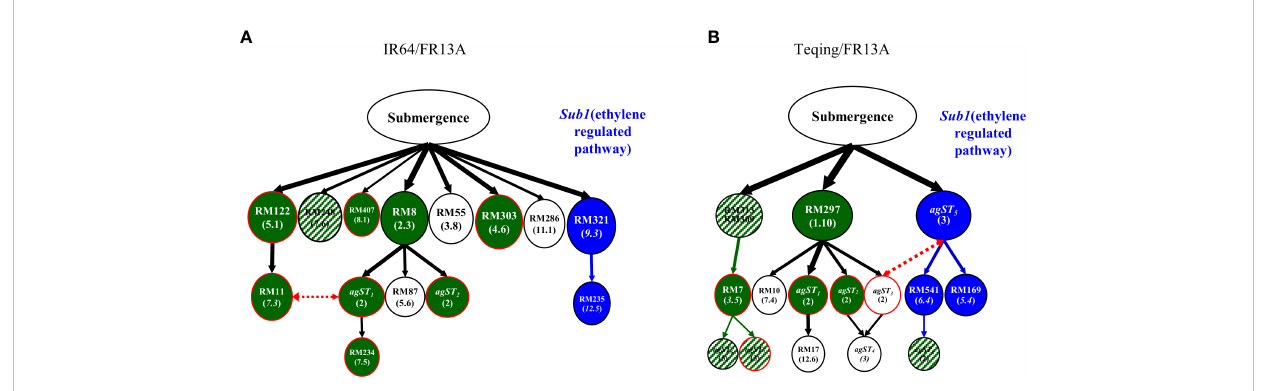
FIGURE 2 Genetic overlap between drought tolerance (DT) and submergence tolerance (ST) revealed in genetic networks (multi-locus structures) constructed from ST loci from the two BC 2 F 2 populations, in which each oval represents a locus or association group (AG) identi fi ed in 14 BC 2 F 2 plants selected under submergence stress from population IR64/FR13A//IR64 (A) and from eight BC 2 F 2 plants of population Teqing/FR13A//Teqing (B) (Wang et al., 2015). Those loci in green color were detected as ST loci identi fi ed in the ten BC 2 F 4 lines selected fi rst for DT and then for ST from population A and in 13 BC 2 F 4 lines selected for DT-ST from population B (Table S3), respectively, while those ovals in patched green represent loci detected with closely linked markers of the same bins. Those ovals with red borderlines were DT loci identi fi ed in the same populations, while those ovals in blue and while colors were not detected in the DT-ST lines in the two